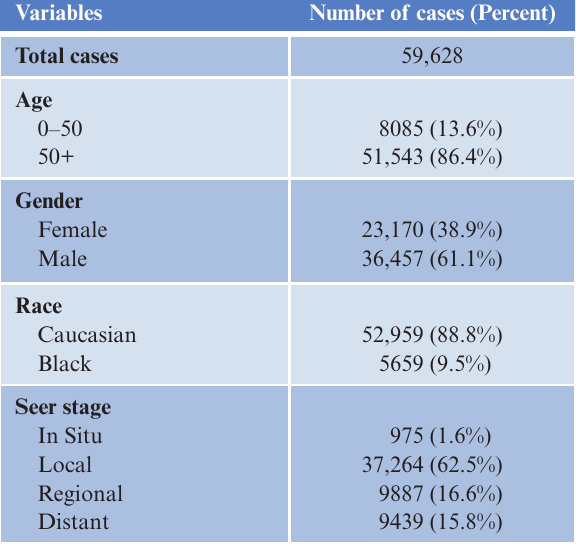
Table 1: Characteristics of patients diagnosed with renal cell carcinoma in the Pennsylvania Cancer Registry from 1990 to